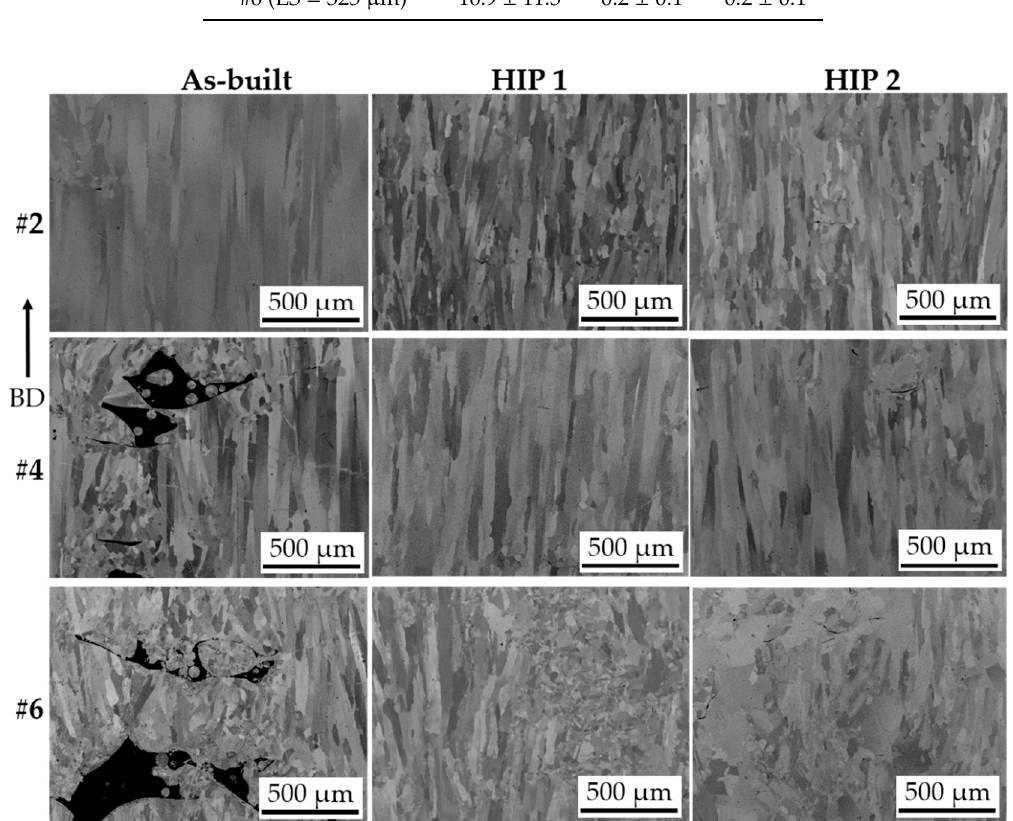
Figure 3. SEM micrographs showing defects in samples #2 (LS = 125 µm), #4 (LS = 225 µm), and #6 (LS = 325 µm) in as-built and HIP’ed conditions. The arrow indicates the build direction.